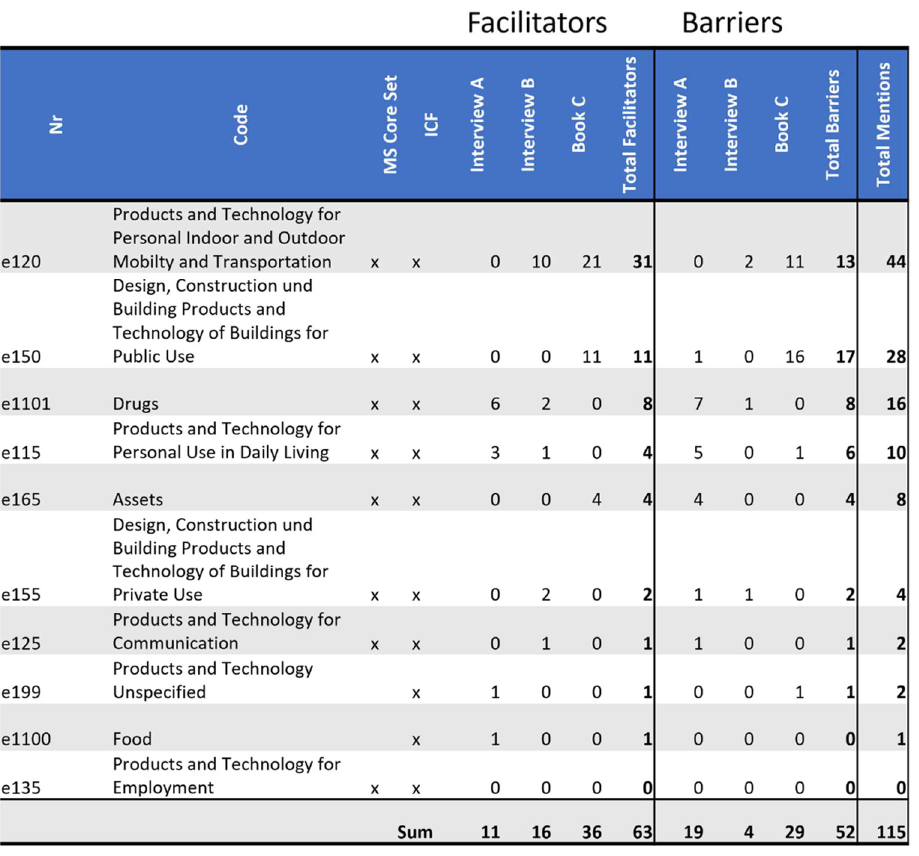
Figure 4. Distribution of codes in the domain e1 Products and Technology : This figure shows the frequency of MS core set codes and non-core set codes of this domain, referenced in each source as a facilitator and as a barrier. Additionally, it tallies all references throughout the domain as facilitators or as barriers by source, as well as tallying facilitators and barriers separately and together by